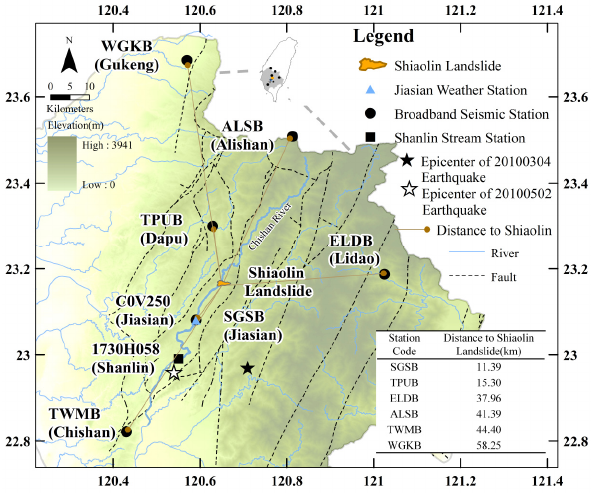
Fig. 2. The locations of the six broadband seismic stations, the Ji- Figure 2The locations of the six broadband seismic stations, the Jiasian rainfall gauge asian rainfall gauge station (C0V250), and the Shanlin stream gauge station (C0V250), and the Shanlin stream gauge station (1730H058). station (1730H058).